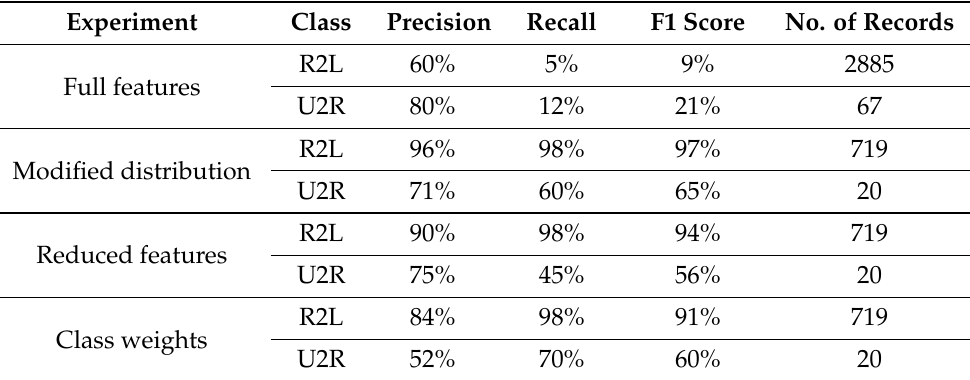
Table 22. Performance metrics for U2R and R2L classes in NSL-KDD multiclass experiments.